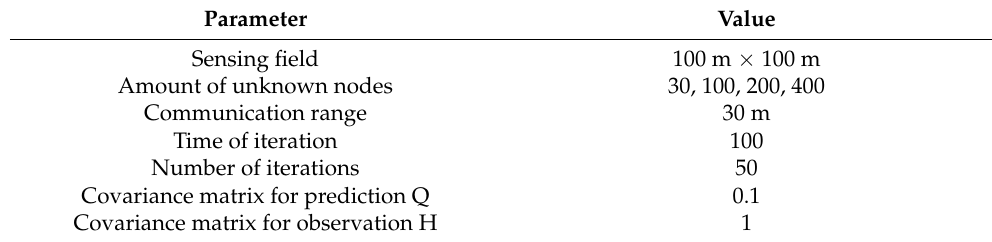
Table 1. Simulation parameters.